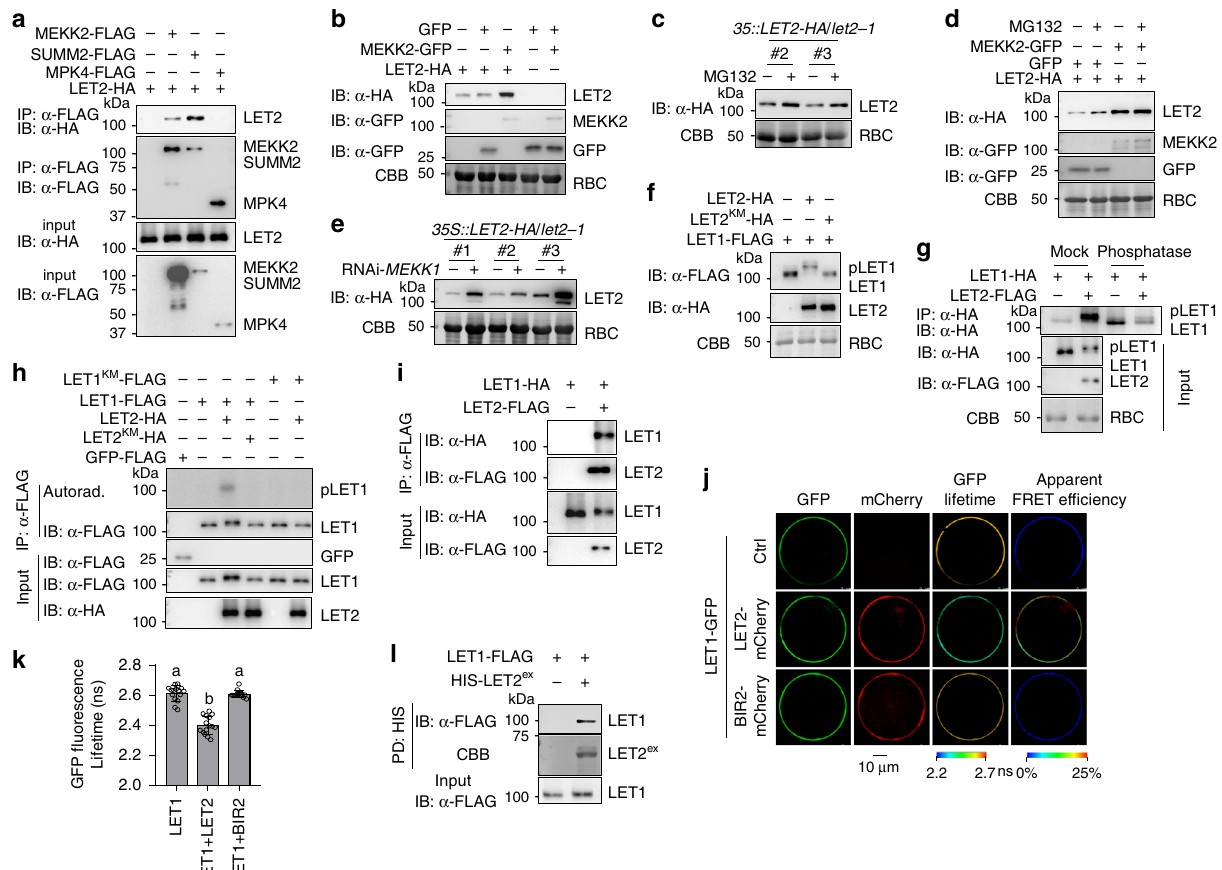
Fig. 4 LET1 and LET2/MDS1 regulation and heteromerization. a LET2/MDS1 associates with MEKK2 and SUMM2, but not MPK4. LET2-HA was co- expressed with Ctrl, MEKK2-FLAG, SUMM2-FLAG, or MPK4-FLAG in protoplasts for 12h. The FLAG-tagged proteins were immunoprecipitated by α -FLAG af fi nity beads, and then immunoblotted by an α -HA or α -FLAG antibody (top two panels). The proteins before immunoprecipitation were immunoblotted by an α -HA or α -FLAG antibody as inputs (bottom two panels). b MEKK2 stabilizes LET2/MDS1 protein accumulation in N. benthamiana . LET2-HA or GFP was co-expressed with MEKK2-GFP or GFP in N. benthamiana for 3 days. The proteins were immunoblotted by an α -HA or α -GFP antibody. CBB staining of RBC was used as a loading control. c MG132 treatment increases LET2/MDS1 protein accumulation in transgenic plants. The 10-day-old seedings of 35S::LET2-HA/ let2-1 (Line #2 and #3) transgenic plants were treated with DMSO (Ctrl) or 5 μ M MG132 for 6 h. Proteins were immunoblotted using an α -HA antibody, and CBB was used as a loading control. d MG132 treatment increases LET2/MDS1 protein accumulation in N. benthamiana . The leaves of N. benthamiana were inoculated with Agrobacterium carrying LET1-HA and GFP , or LET1-HA and MEKK2-GFP for 12h, and then treated with DMSO (Ctrl) or 5 μ M MG132 for anthor 36 h. Proteins were immunoblotted by an α -HA or α -GFP antibody. CBB was used as a loading control. e Silencing MEKK1 increases LET2/MDS1